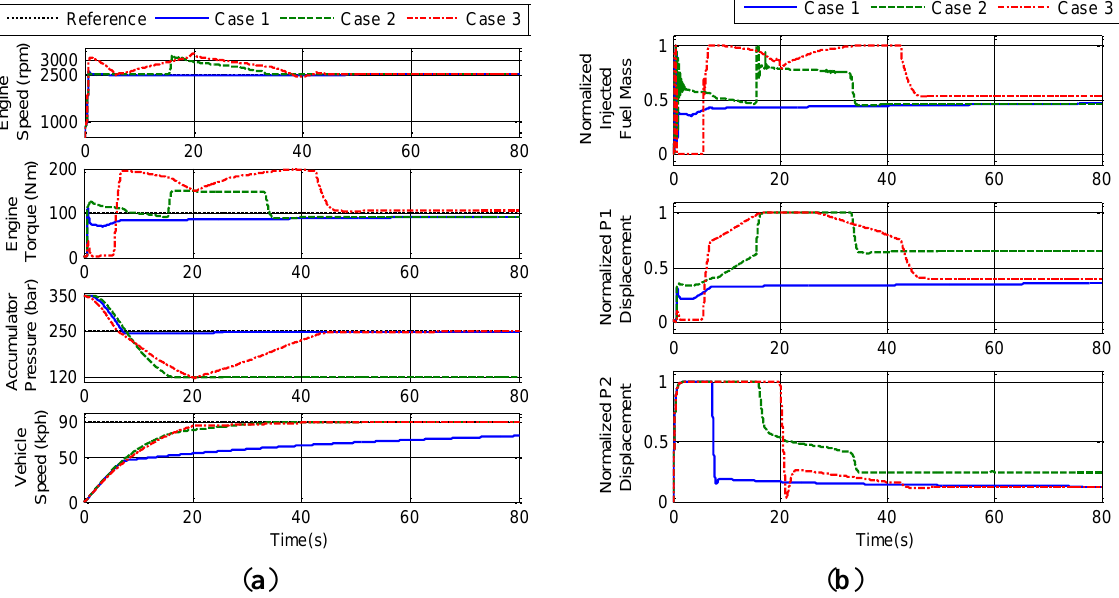
Figure 9. Effect of weight factors on system performance: ( a ) Outputs; and ( b )